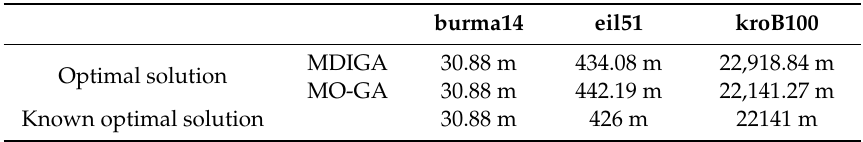
Table 1. Comparative results of planned path length using the multi-offspring method (MO-GA) and multi-domain inversion-based algorithm (MDIGA).